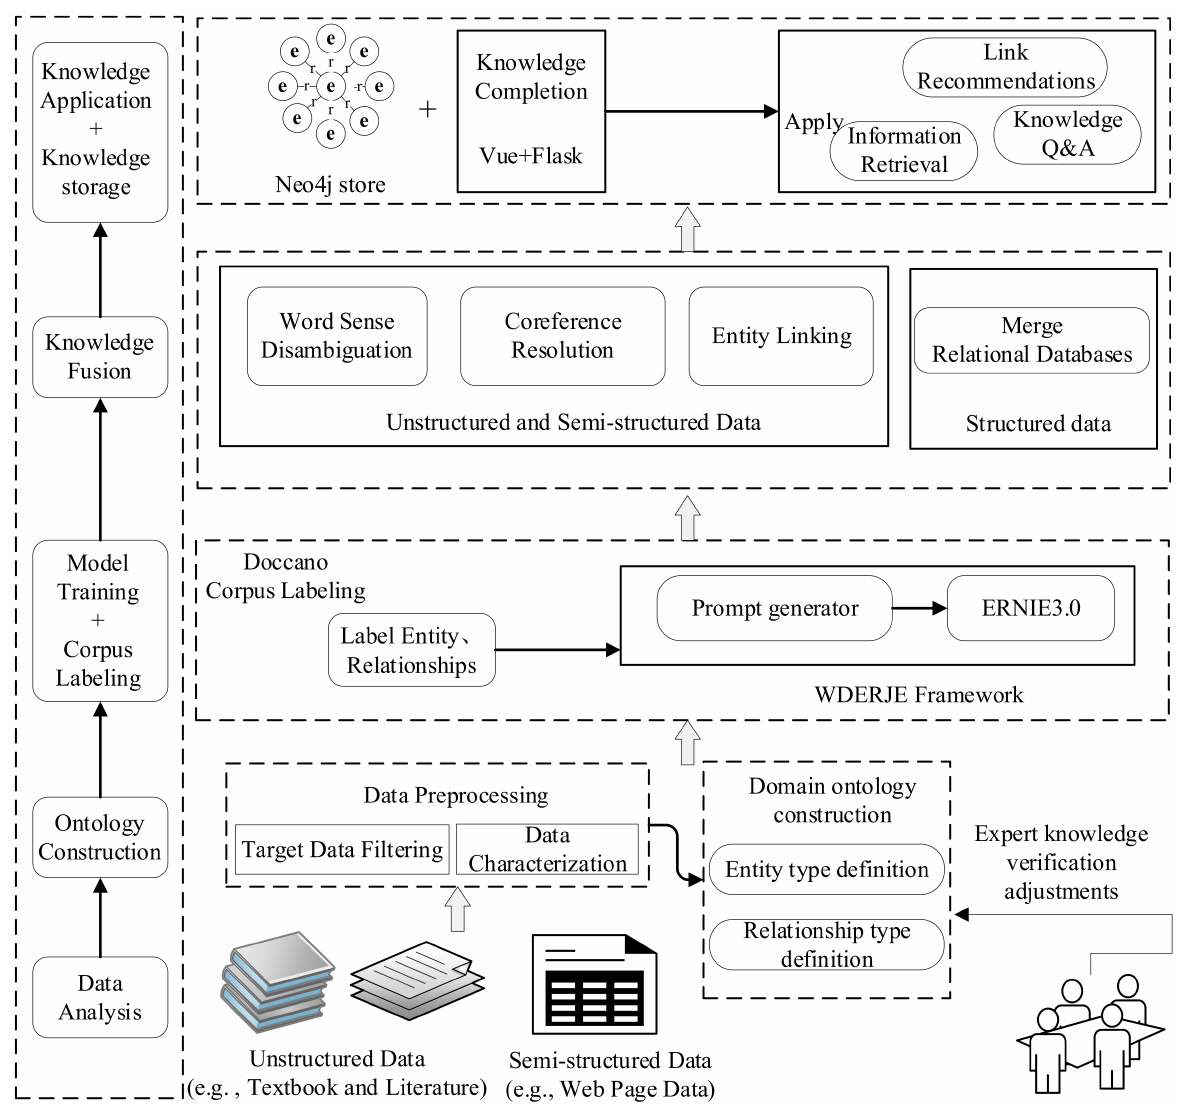
Figure 1. Overall Construction